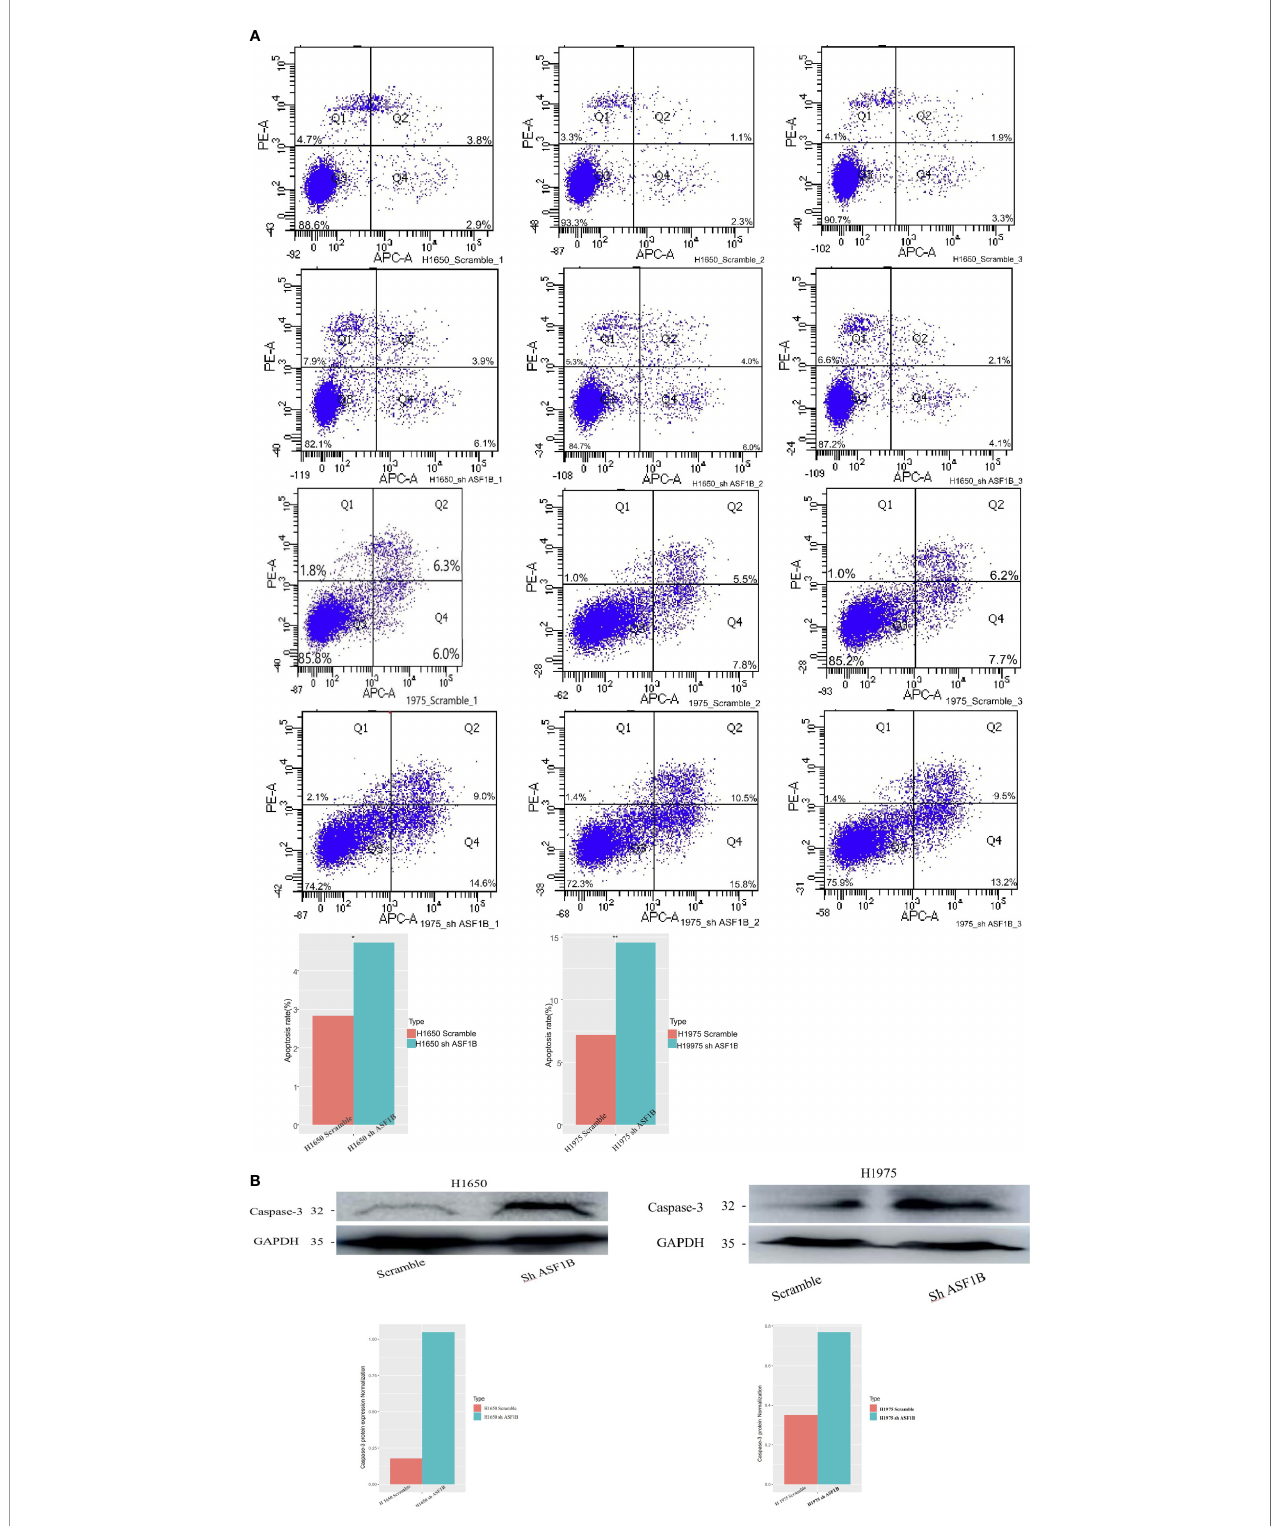
FIGURE 9 | (A) Flow cytometry was used to detect the early apoptosis changes in H1975 and H1650. (B) Western blot was used to detect the protein levels of apoptosis-3 in H1650 and H1975 cells treated with knockout-ASF1B and untreated control cells. *p vaule ≤ 0.05; **p vaule ≤